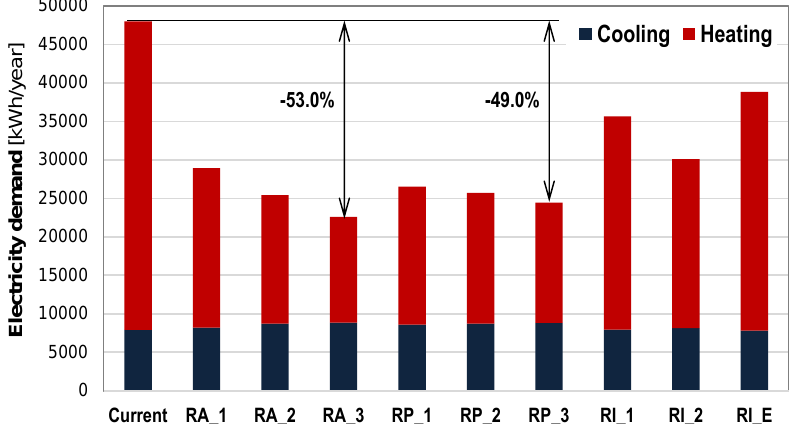
Figure 5. Annual electricity needs for space heating and cooling.